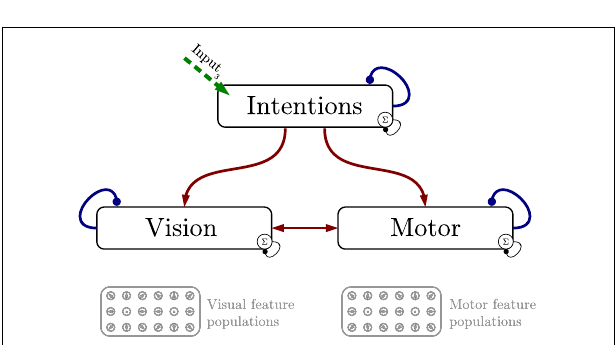
FIGURE 10 | Experiment 3: movement simulation with visuomotor coupling . No sensory signal is provided. While the stochastically emerging visual and motor states are biased by the top-down predictions induced by a constant intention signal, the coupling between vision and motor codes ensures the synchronization of the simulated pattern